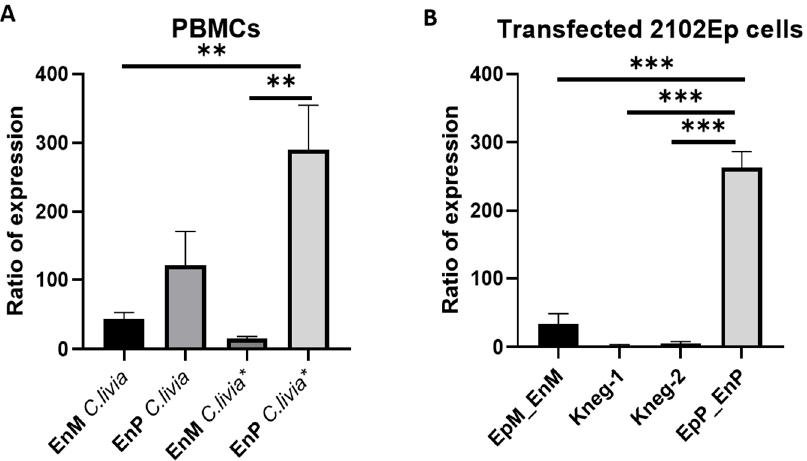
Figure 6. Quantitative analysis of the M and P gene transcripts. ( A ) PBMC (peripheral blood